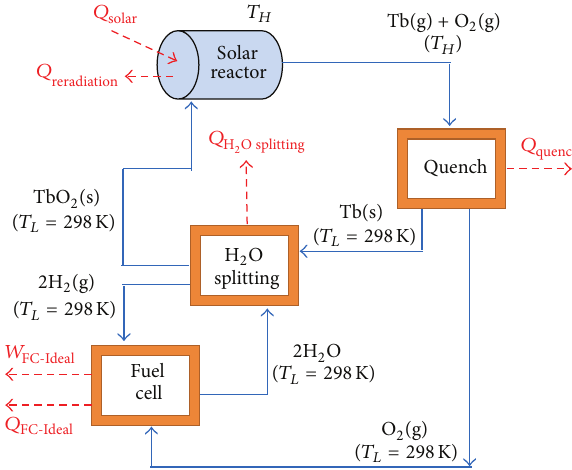
Figure 5: Process flow diagram for H 2 production via Tb-WS